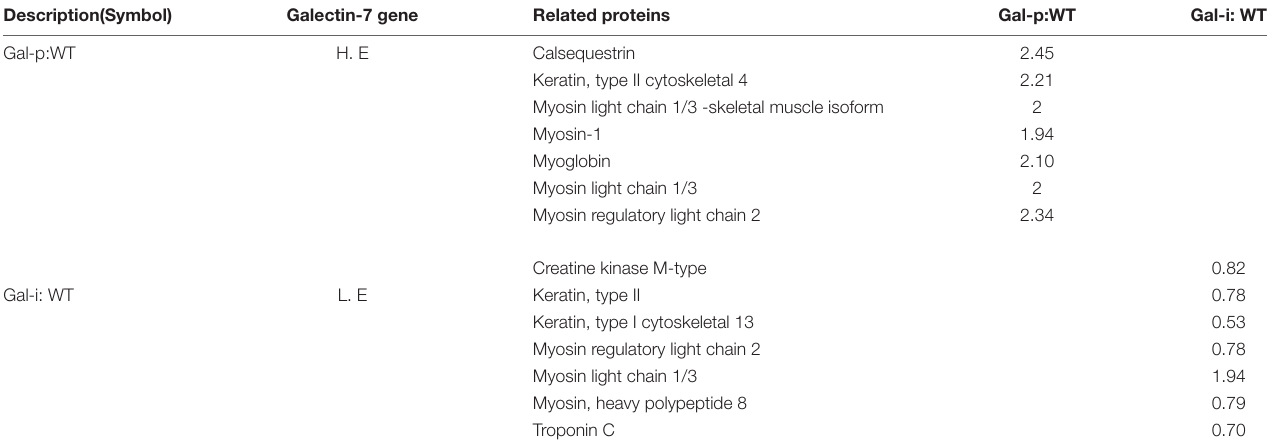
TABLE 3 | Detection of galectin-7-related differentially expressed proteins through iTRAQ, gene ontology (GO), and KEGG analyses. Description(Symbol)